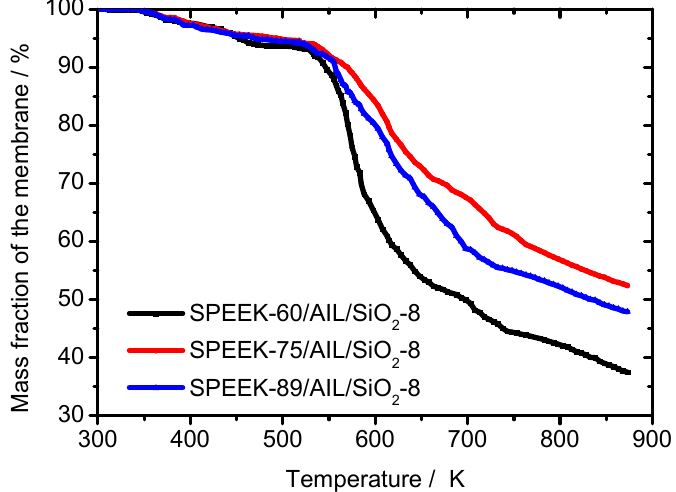
Figure 5. Thermogravimetric analysis (TGA) of the SPEEK/AIL/SiO 2 composite membranes.